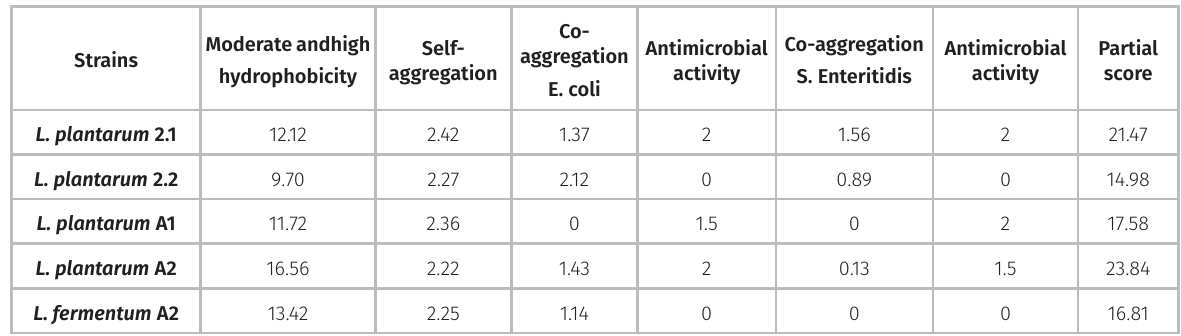
Table III. Partial score based on the values presented for each property mentioned by strain and on the established